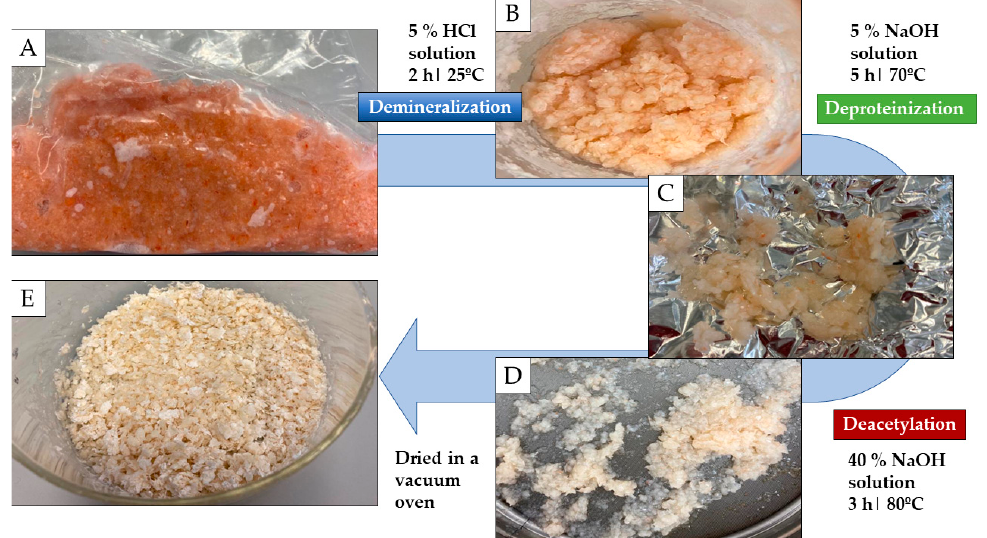
Figure 6. Chemical chitosan extraction. ( A ) Crushed exoskeletons. ( B ) Crushed exoskeletons after acid treatment. ( C ) Residue after diluted soda treatment. ( D ) Residue after concentrated soda treatment. ( E ) Chitosan flakes.